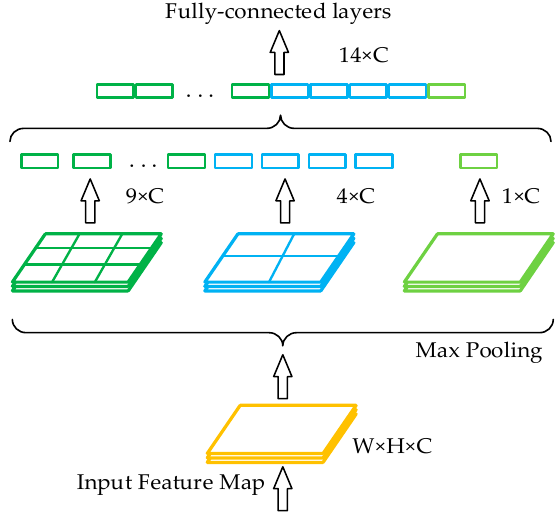
Figure 4. Spatial pyramid pooling.